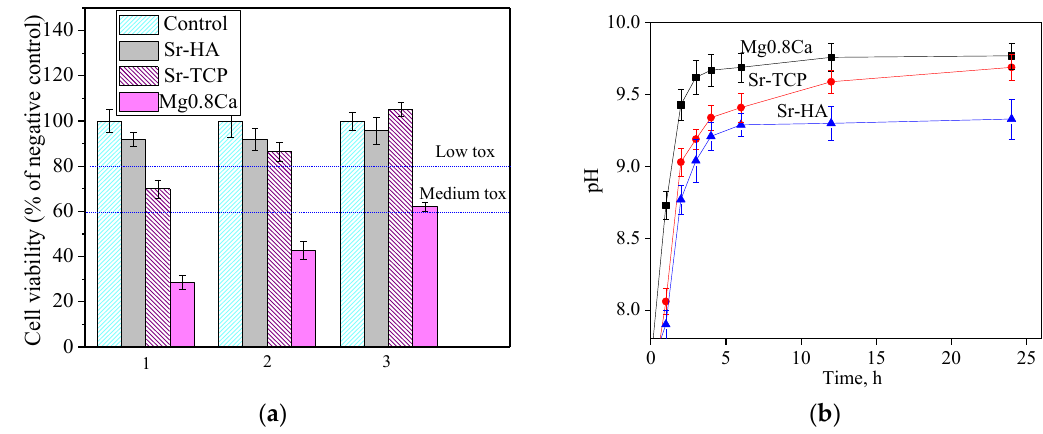
Figure 14. ( a ) Results of in vitro cytotoxic test of Mg.08Ca, Sr-HA and Sr-TCP samples extracts measured by an MTT assay (1); when extracts were diluted 10 (2) and 100 (3) times and ( b ) kinetics of pH changes in the cell medium during interaction with the samples.